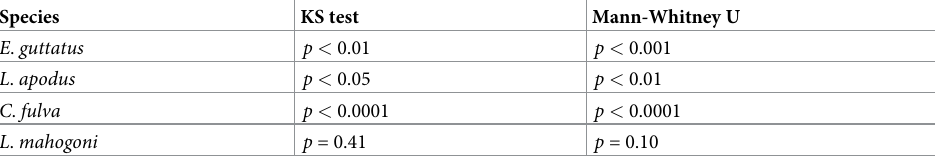
Table 9. Results of size distribution tests for the MNTZ.